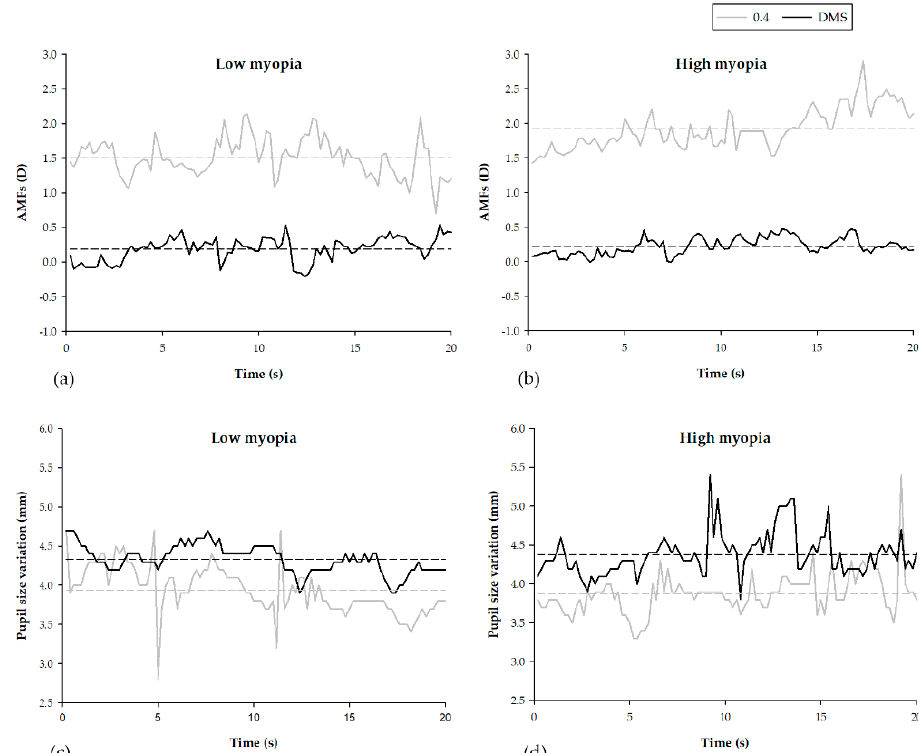
Figure 5. The accommodative response microfluctuations (AMFs) and pupil size variation at different viewing distances of 0.4 m, and through a DMS. ( a , b ) The accommodative response microfluctuations (AMFs). ( c , d ) The pupil size variation for the both of the low and high myopia subjects, respectively.